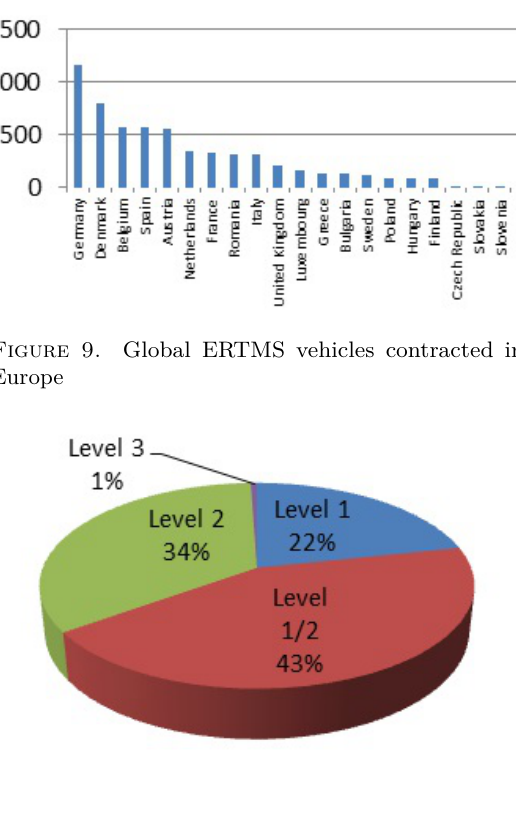
Figure 8. TRACKS in EU separated by level